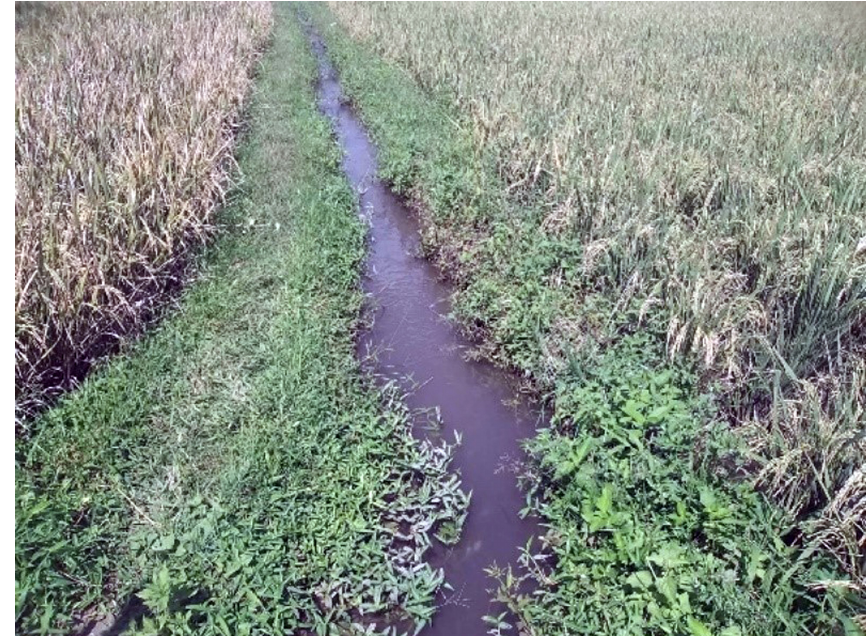
Fig. 5. Over-watered mature rice plant in the upper area. Source: photo taken by the